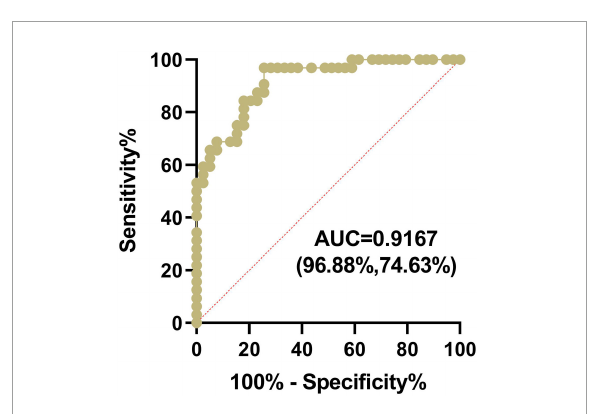
FIGURE3 The ssDNA antibodies in plasma can serve as a diagnostic marker for HSCR. The Plasma ssDNA antibodies from the HSCR and control group were measured by ELISA, and the sensitivity and specificity of ssDNA antibodies for HSCR diagnosis were subjected to AUC